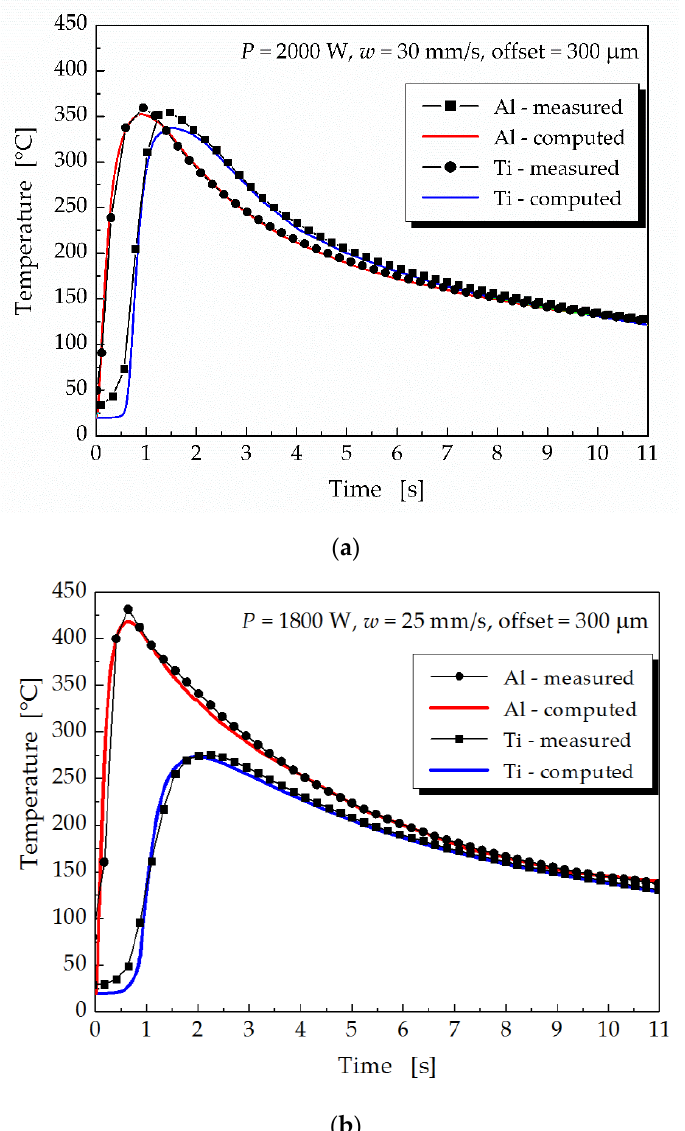
Figure 7. Computed and experimentally measured thermal cycles in welding – brazing ( a ) sample 2 and ( b ) sample 6.